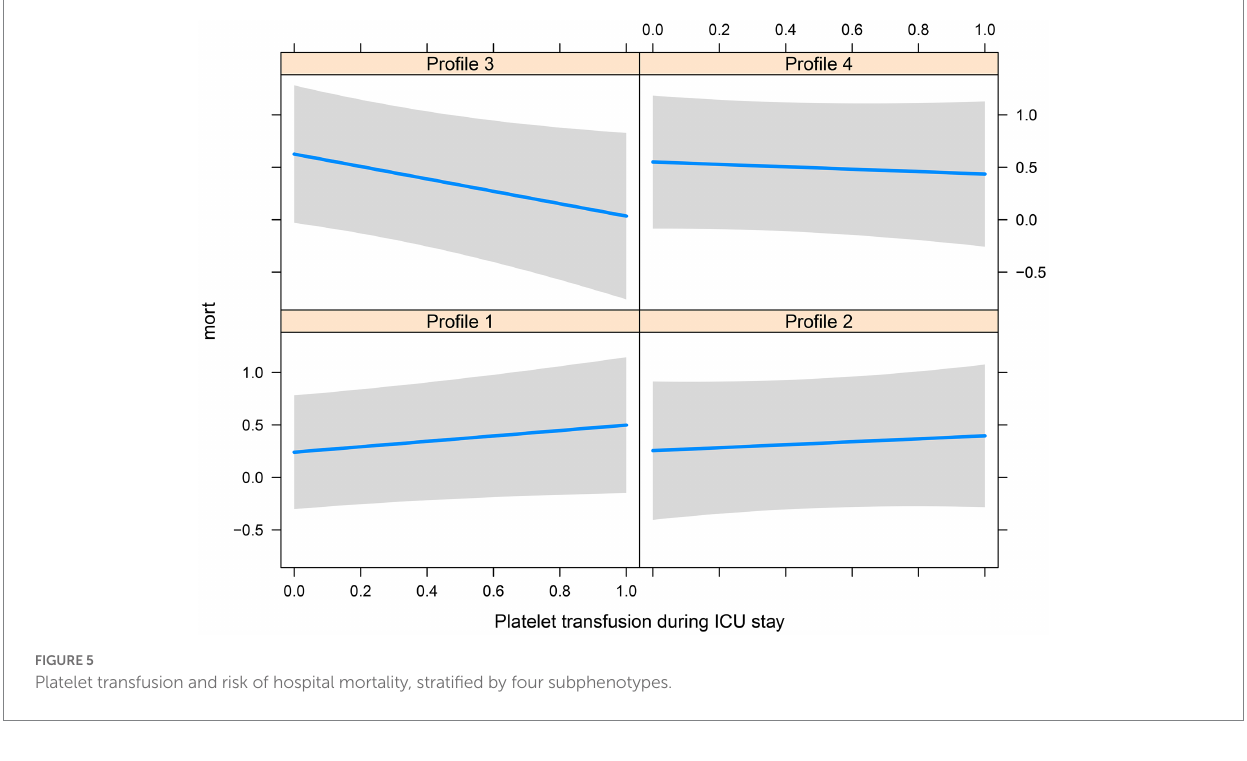
FIGURE 5 Platelet transfusion and risk of hospital mortality, stratified by four